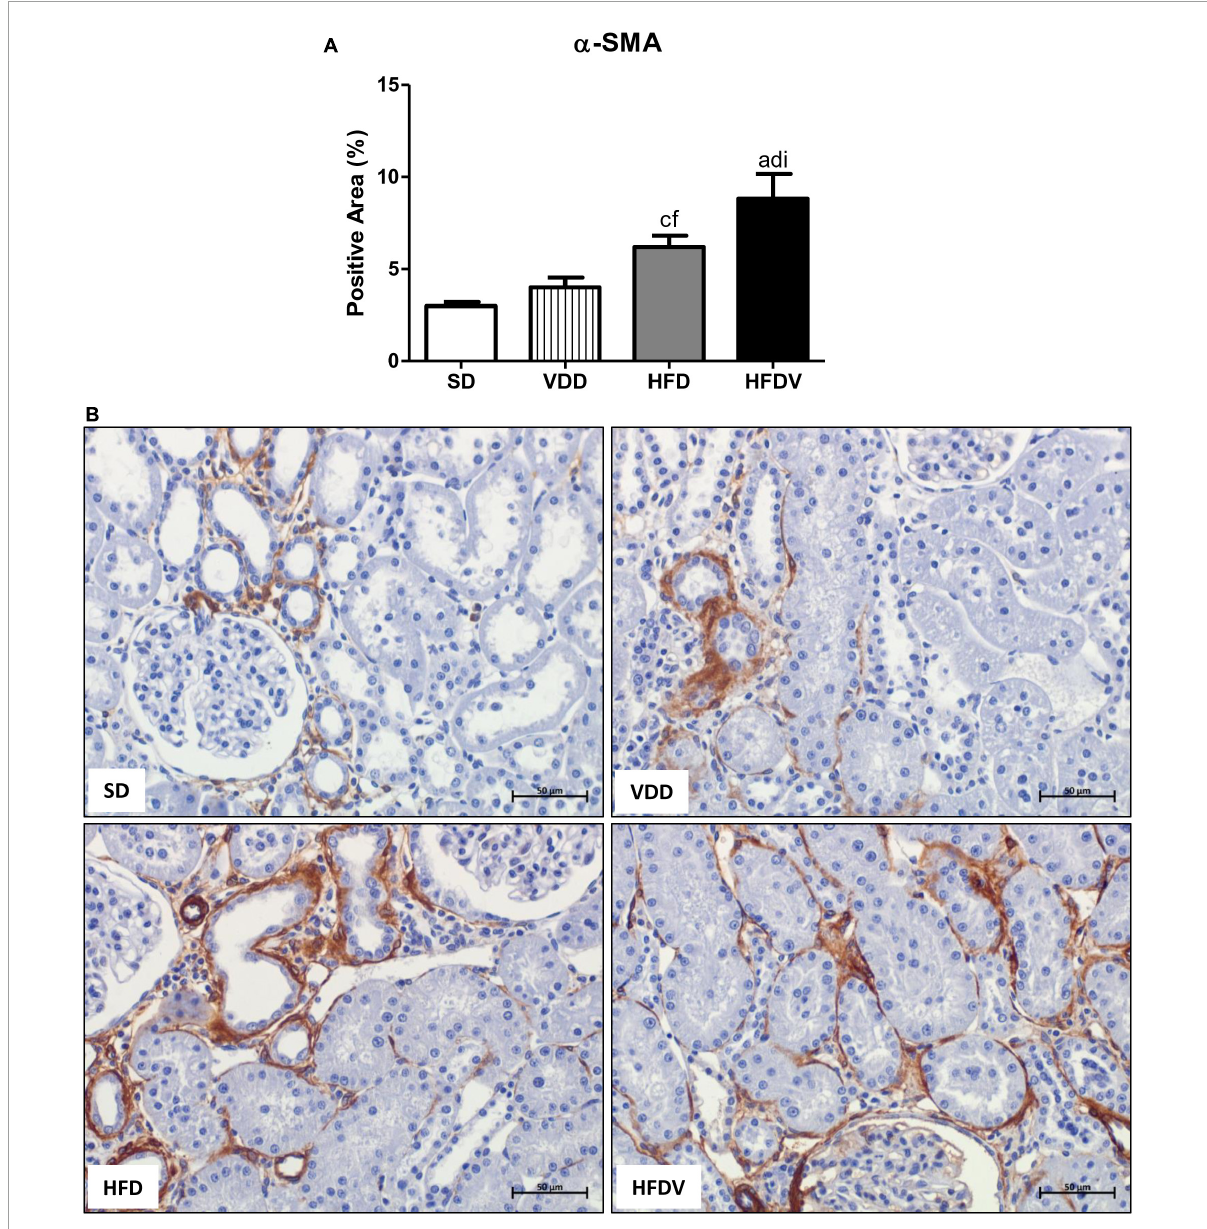
FIGURE9 Immunohistochemical analysis for α -smooth muscle actin ( α -SMA) expression in the renal cortex evaluated after the 90-day protocol in rats submitted to renal ischemia-reperfusion insult on day 45 treated with standard diet (SD), vitamin D-free diet (VDD), high-fat diet (HFD) or high-fat vitamin D-free diet (HFDV). (A) Bar graph of α -SMA expression values. (B) Representative photomicrographs of immunostaining for α -SMA in the renal cortex from an SD, VDD, HFD, and HFDV rat (400 × ). Data are mean ± SEM. a p < 0.001 and c p < 0.05 vs. SD; d p < 0.001 and f p < 0.05 vs. VDD; i p < 0.05 vs .